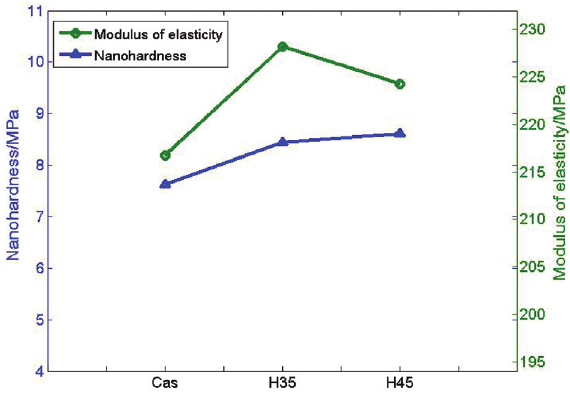
Figure 7: The variation of nanohardness and elastic modulus after HI.